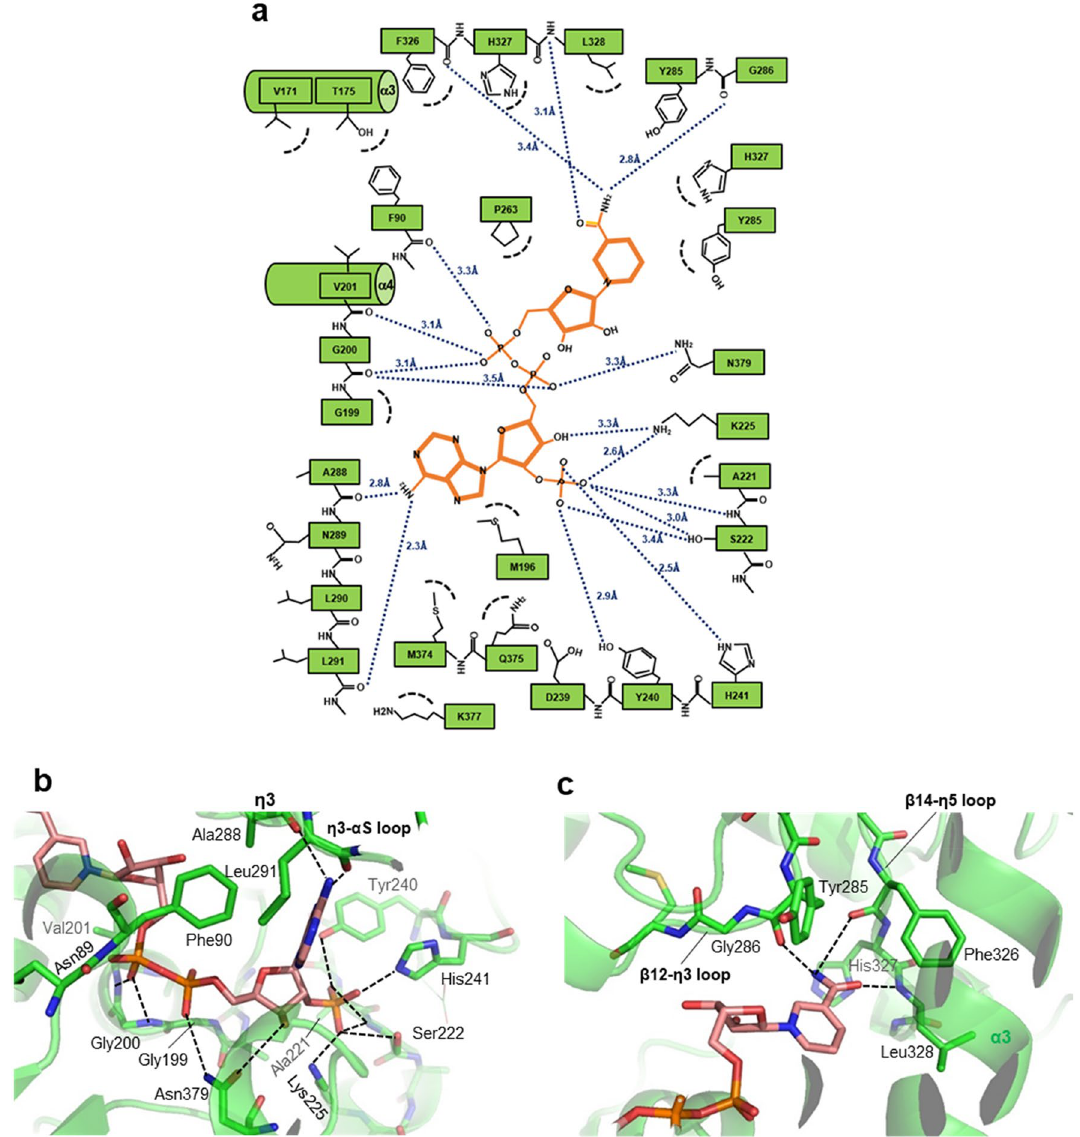
Figure 3. NADP bound to VAT-1. ( a ) Graphical summary of the NADP-VAT-1 interactions calculated by LIGPLOT 33 . ( b ) The ADP moiety of the bound NADP forms 12 hydrogen bonds with VAT-1. ( c ) The NMN moiety of the bound NADP forms 6 hydrogen bonds with